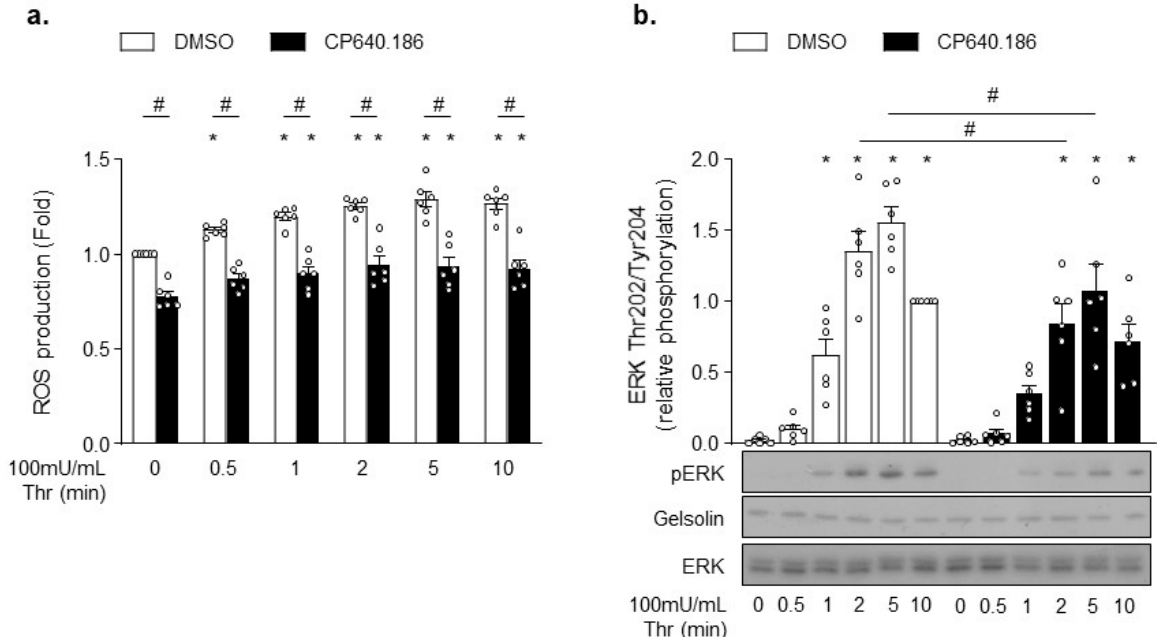
Figure 5. CP640.186 decreases thrombin-induced reactive oxygen species (ROS) production and ERK phosphorylation. ( a , b ) Washed human platelets were pre-incubated for 2 h with dimethyl sulfoxide (DMSO) or CP640.186 (60 µ M) before being either stimulated or not with thrombin (100 mU/mL) at different time points. ( a ) Reactive oxygen species (ROS) were detected by means of flow cytometry using H 2 DCFDA (10 µ M) probe. Data were expressed as means ± SEM ( n = 6). * p -value ≤ 0.05 in relation to unstimulated conditions. # p -value ≤ 0.05 in relation to DMSO conditions. Data were compared using 2-way ANOVA (analysis of variance). ( b ) Whole platelet lysates were subjected to western blot and probed with phosphoERK, ERK, or gelsolin antibodies. Data were expressed as means ± SEM ( n = 6). * p -value ≤ 0.05 in relation to unstimulated conditions. # p -value ≤ 0.05 in relation to DMSO conditions. Data were analyzed using 2 − way